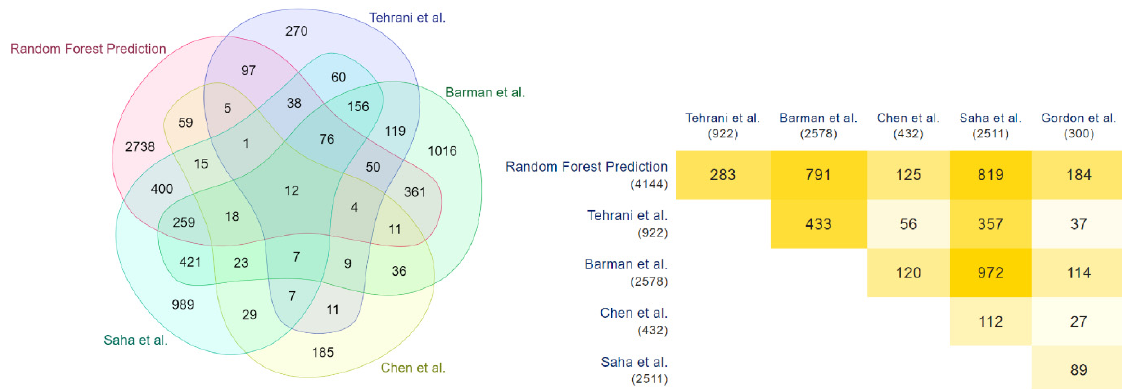
Figure 5. Overlapping of XGBoost and other methods predicted COVID-19 human drug targets.